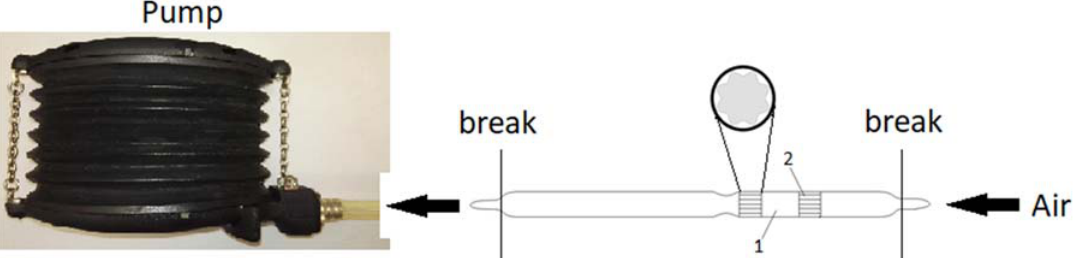
Figure 1. Detection tube design (1—indication charge; 2—PE element) and its use.